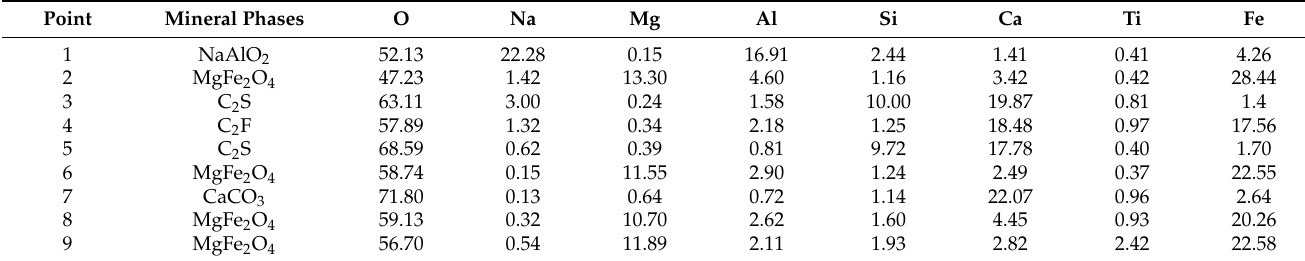
Table 4. EDS results of di ff erent points (1–9) corresponding to those in Figures 13a and 12d,f (in %).